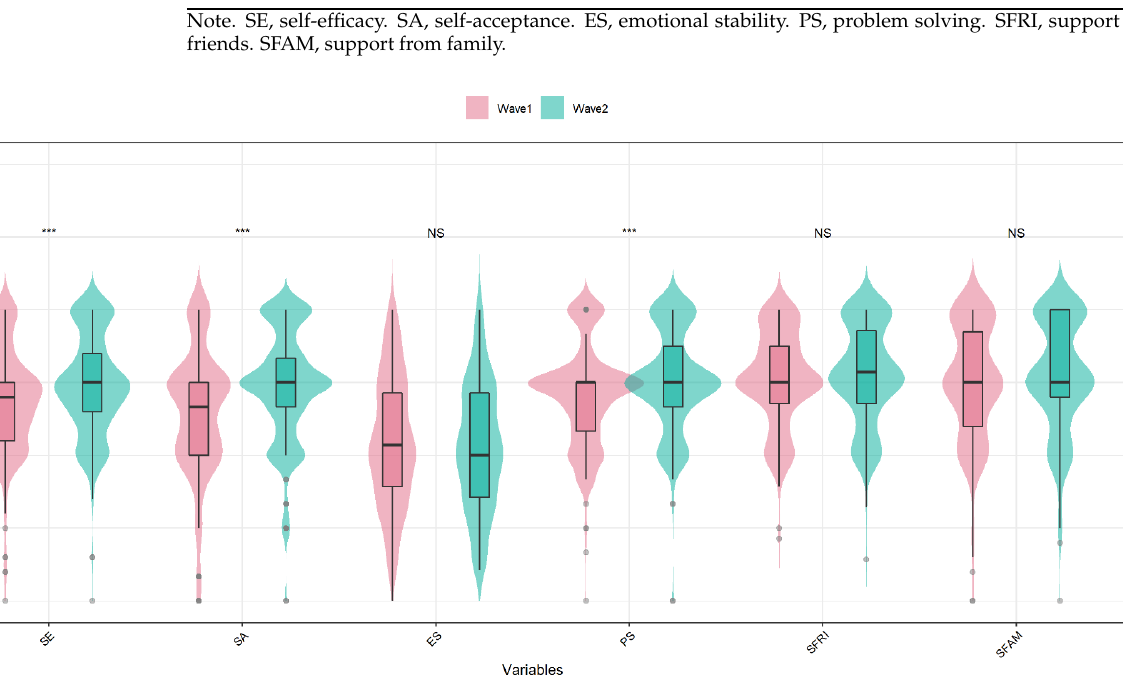
Figure 1. The plot of means in the paired t -test among wave 1 and wave 2. *** p <